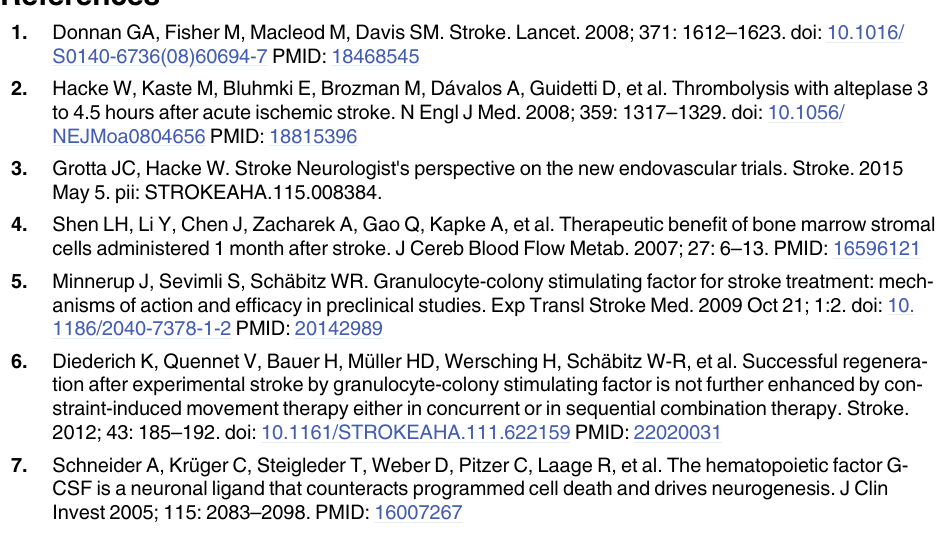
S1 Table. Neuron summary ipsilateral layer V. S2 Table. Neuron summary contralateral layer